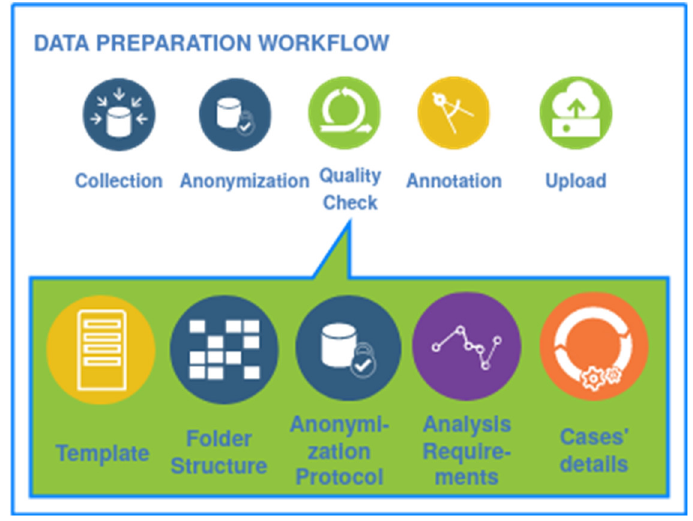
Figure 2. Data preparation workflow.